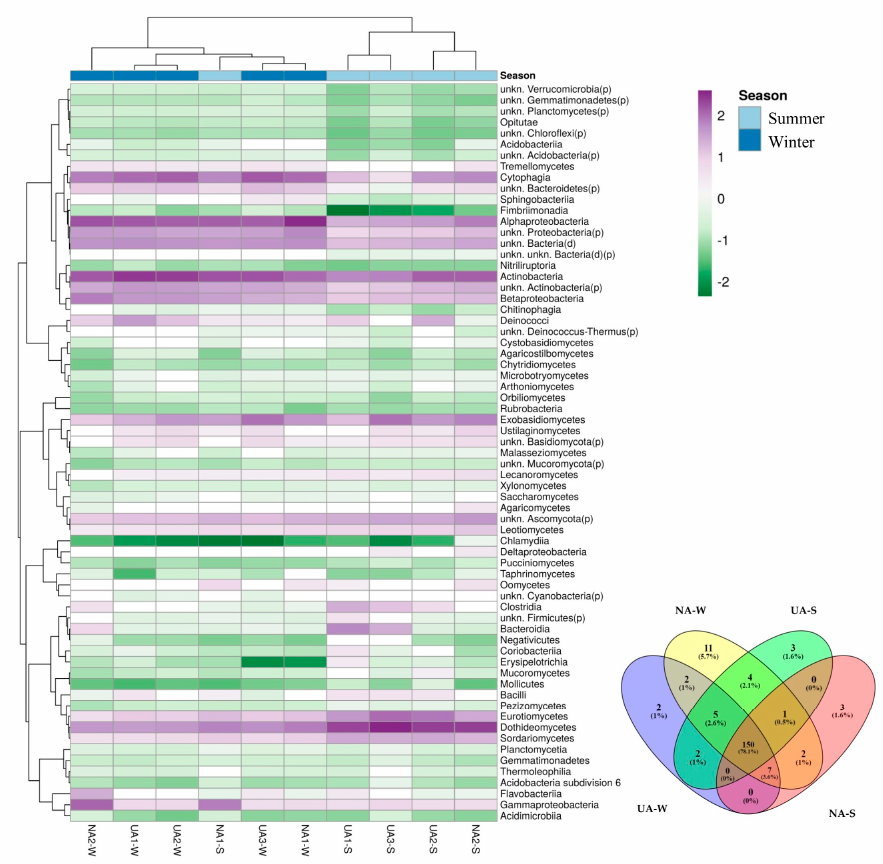
26.7% of the nodes in the entire network (Figure S1 in Supporting Information), which corresponds to 39 OTUs. Module III and IV occupy 21.2% and 16.4% of the nodes, re- spectively, whereas module V consisted of 8.9% of OTUs.